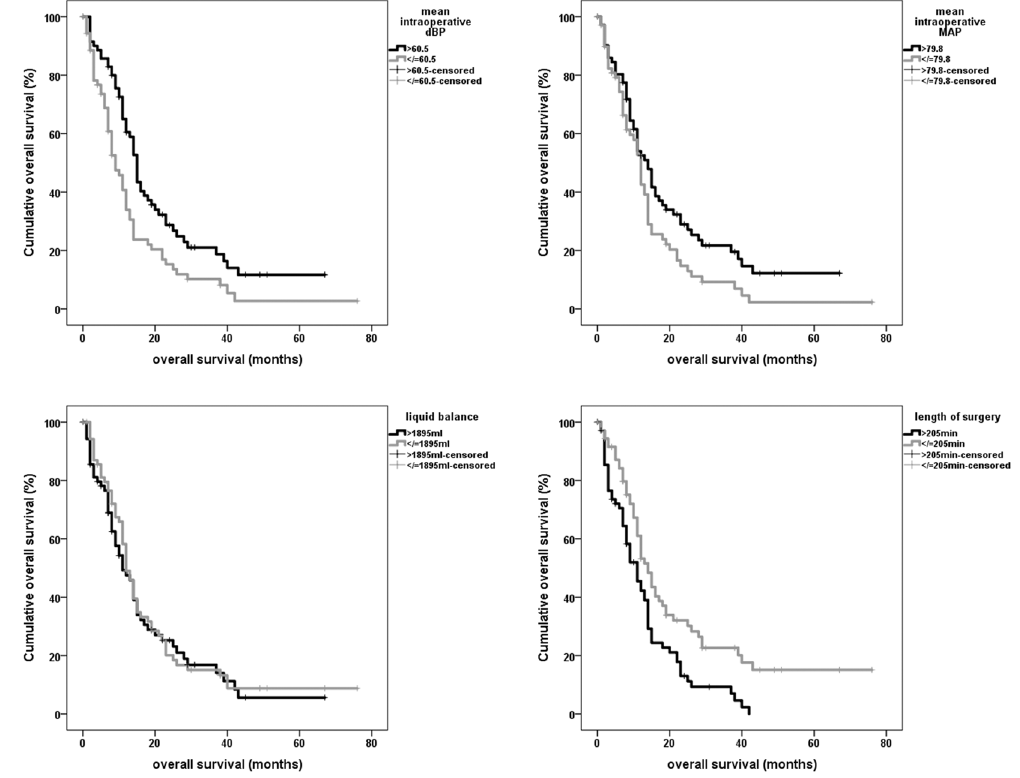
Figure 3. Kaplan Meier estimates for dichotomized mean diastolic blood pressure, MAP, liquid balance and length of